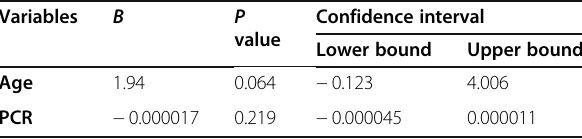
Table 5 Linear regression analysis to predict SVR VEGF values in HCV patients